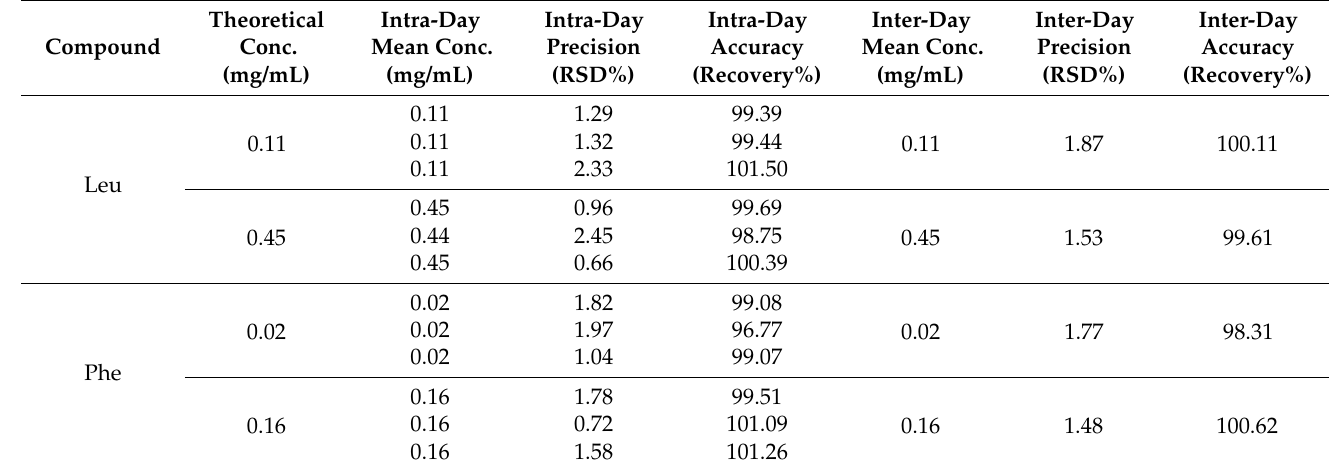
Table 2. Method validation: evaluation of precision (RSD%) and accuracy (Recovery%) in the short- and log-term period (intra-day and inter-day precision and accuracy values) for Leu and Phe.